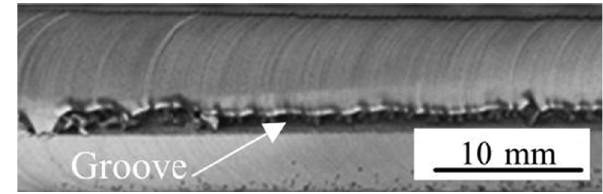
Figure 2: Surface appearance of joints under the gap width of 1 mm and no compensation